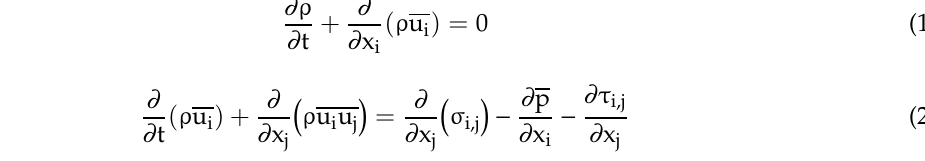
Figure 6. Iso-Surface of instantaneous vorticity magnitude at T* = 9.2.